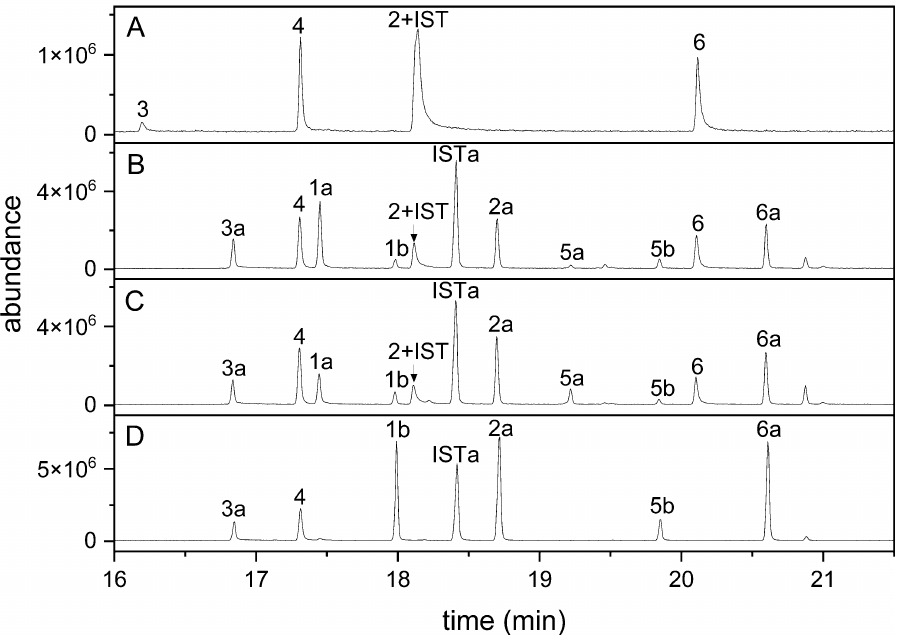
Figure 2. GC detection of indolic carbinols and nitriles after derivatization with different reagents. A mixture of the six indolic glucosinolate breakdown products and I3CN (internal standard, IST) was analyzed by GC-MS without derivatization ( A ) and after incubation in MSTFA ( B ), MSTFA + 1% TMCS ( C ) or MSTFA/pyridine (2 + 1) ( D ) at 70 °C for 1 h. GC-MS total ion current (TIC) traces are shown. Compound numbers the same as in Table 1; suffix a indicates silylation in one position, and suffix b indicates silylation in two positions. Carbinols 1 and 5 can carry two TMS groups; the other compounds can be silylated once, with the exception of 4 (no silylation).